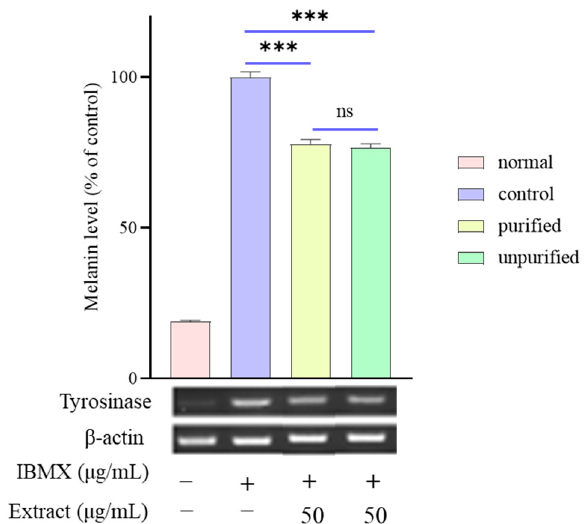
Figure 3. Relative mRNA levels of the melanogenic genes tyrosinase in the B16/F10 cells were quantified using real-time PCR. The β -actin was used as an internal control for equal loading. Data represent the mean ± SD of three independent experiments. *** p -value < 0.001 compared with IBMX induced group. ns: not significant ( p > 0.05).